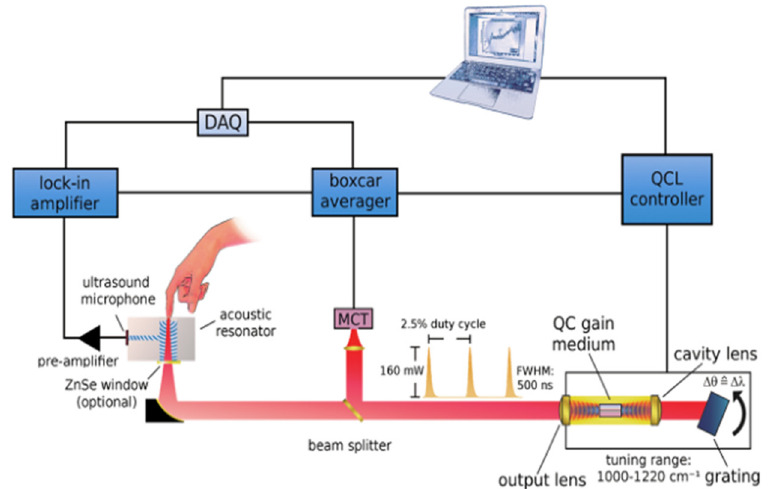
Figure 2. Optical setup and signal detection schematic for the photoacoustic measurement of glucose in skin. Reprinted with permission from [ 42 ]. Copyright 2013 American Chemical Society.